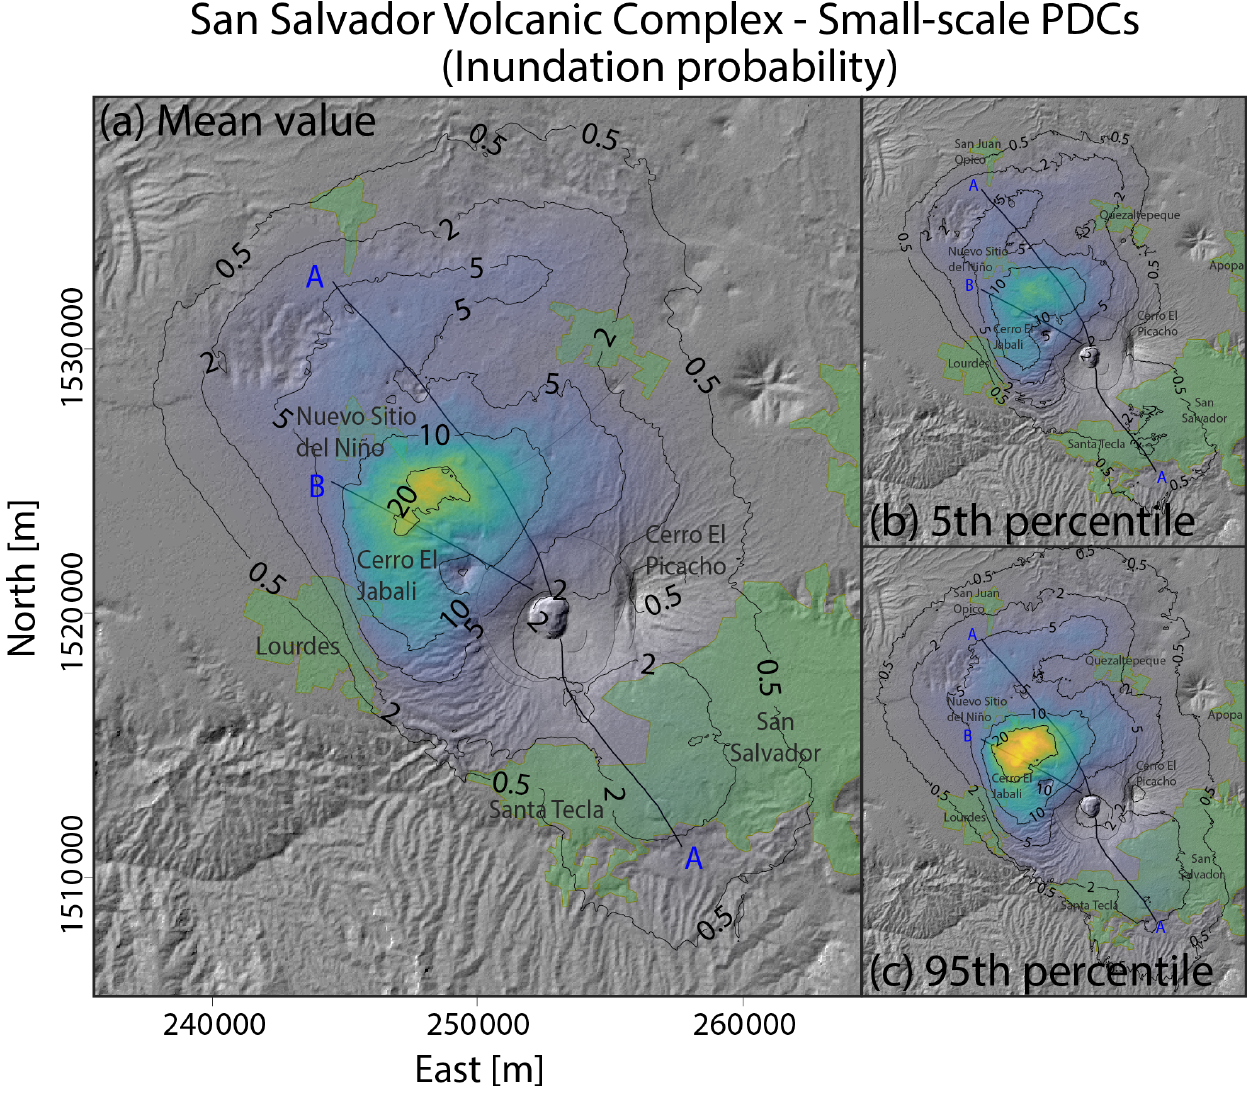
Figure 8. Inundation probability of small-scale PDC at the San Salvador volcanic complex derived from the systematic application of the branching energy cone model (Aravena et al., 2020a) and the vent opening probability map shown in Fig. 4. (a) Mean value. (b) 5th percentile. (c) 95th percentile. Inundation probability is expressed in percentage. These probability maps are conditioned on the occurrence of an eruption able to produce small-scale